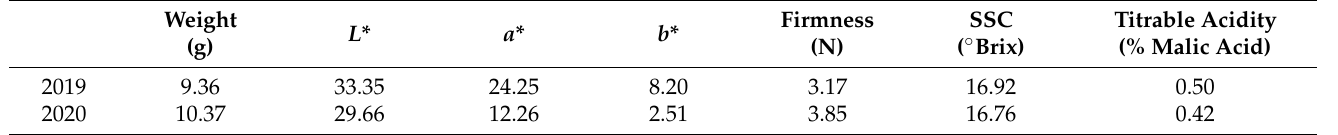
Table 3. Initial values of the physicochemical variables evaluated in the sweet cherry cv. Satin conservation study for each of the 2 years of